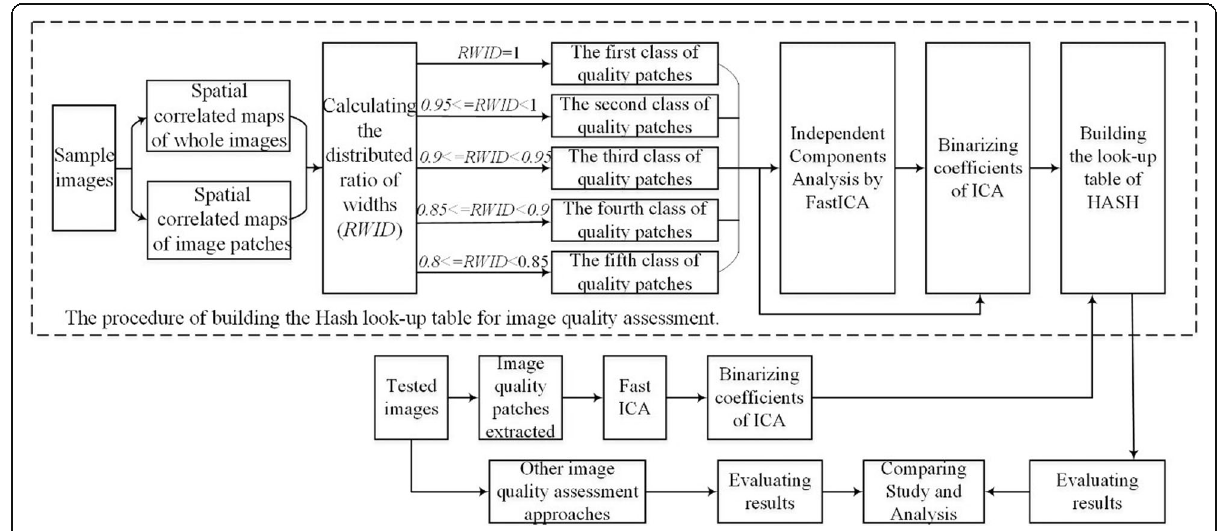
Fig. 1 The mainly operating procedure of the real-time no-reference image quality assessment based on quality